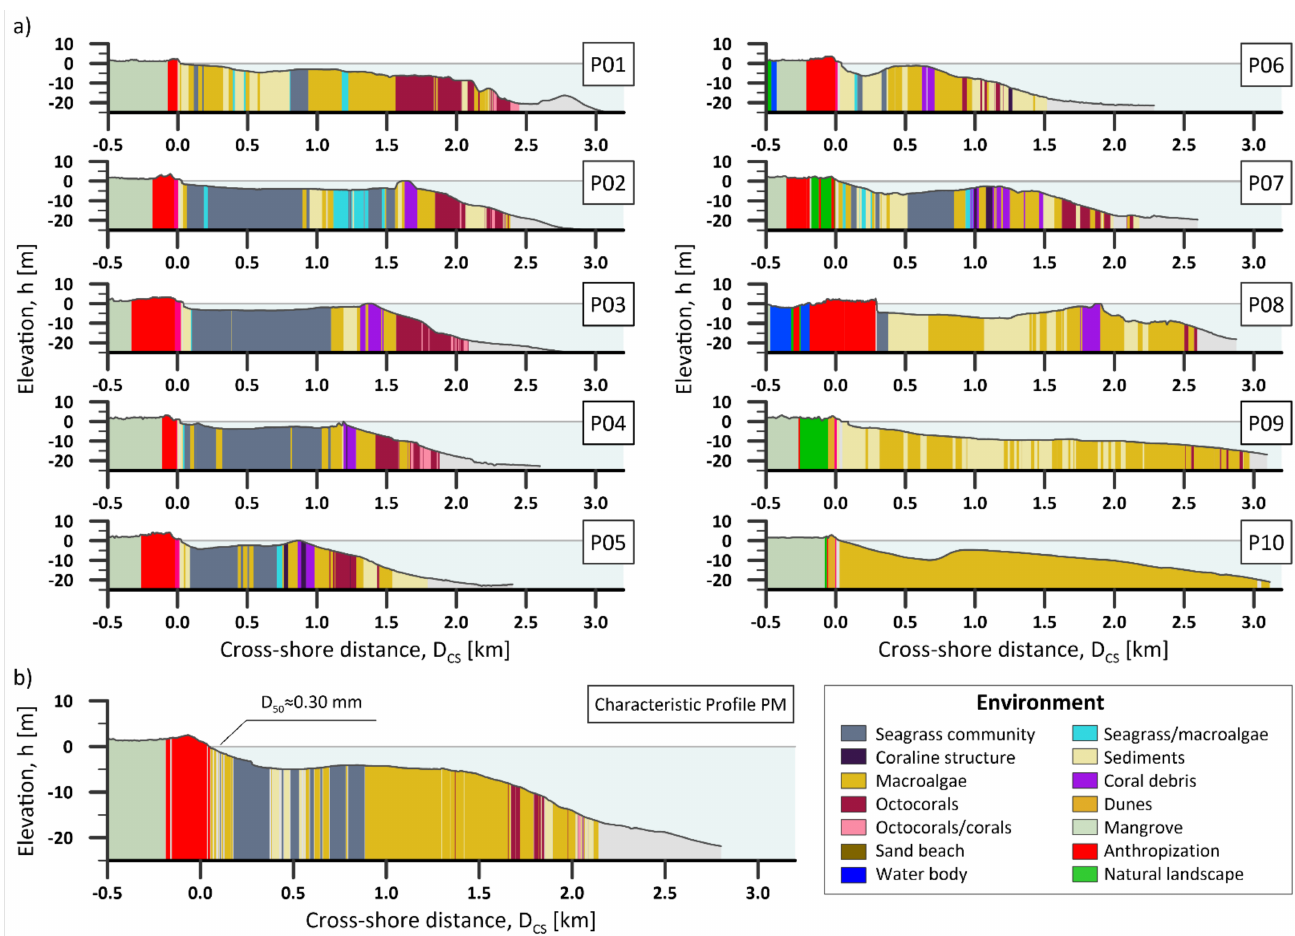
Figure 10. Beach profiles at Puerto Morelos (PM), extending from 500 m inland, towards a water depth of 25 m. The shoreline is located at a cross-shore distance D CS = 0 m. The profiles ( a ) are numbered from north to south as in Figure 1. The land use at Puerto Morelos ( b ) corresponds to profiles P01–P10.